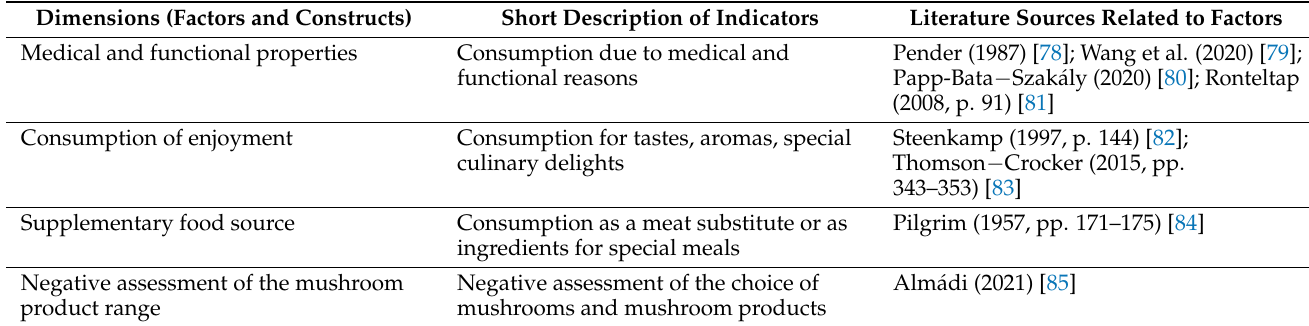
Table 3. Literature sources and empirical studies related to the research